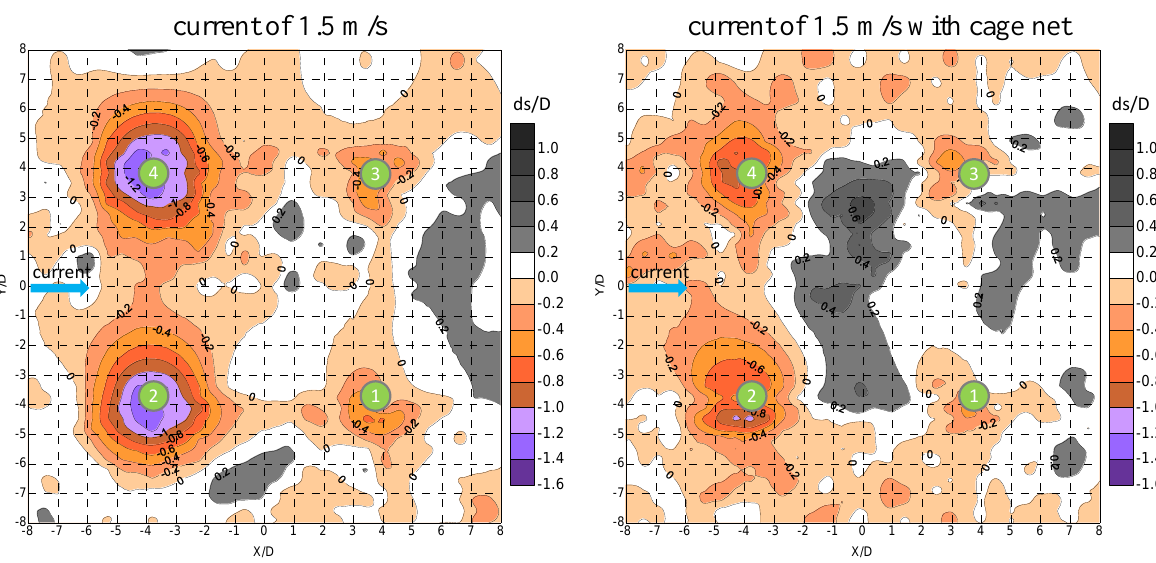
Figure 11. The potential impact erosion area and scouring around four piles of the jacket-type foundation and cage net under the current-alone case (a current of 1.5 m/s). current of 1.5 m/s current of 1.5 m/s with cage